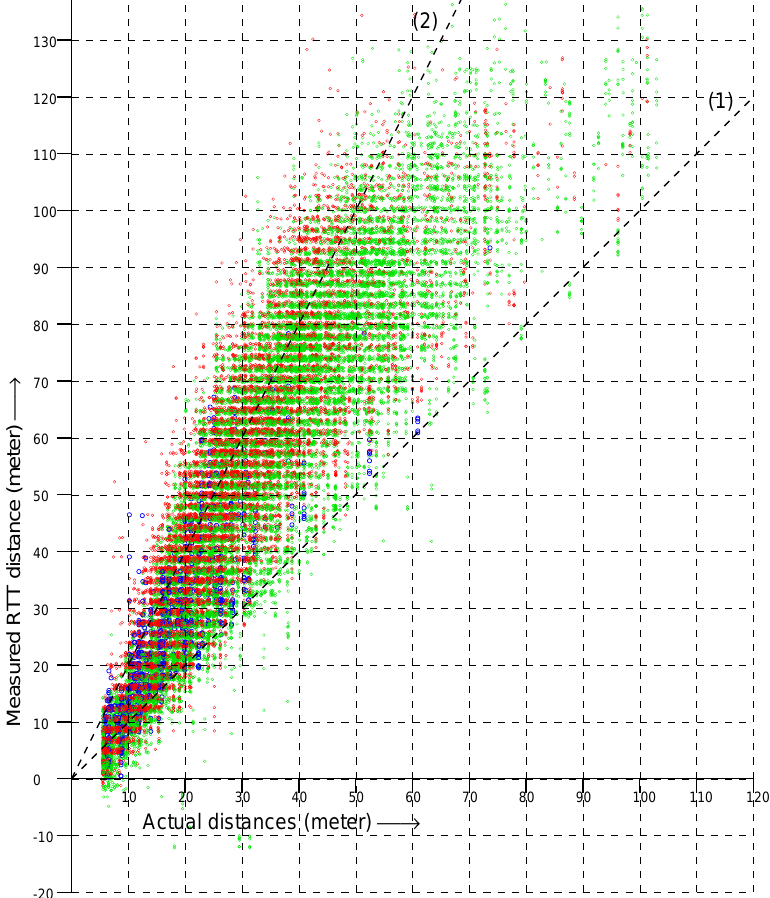
Figure 2. Scattergram of over 32,000 RTT measurements (vertical axis) versus actual distance (hori- zontal axis). (Green, measurements in the 2.4 GHz band; red, in the lower and upper 5 GHz band; blue, in the DFS part of the 5 GHz band). Dashed lines indicate slope (1) and